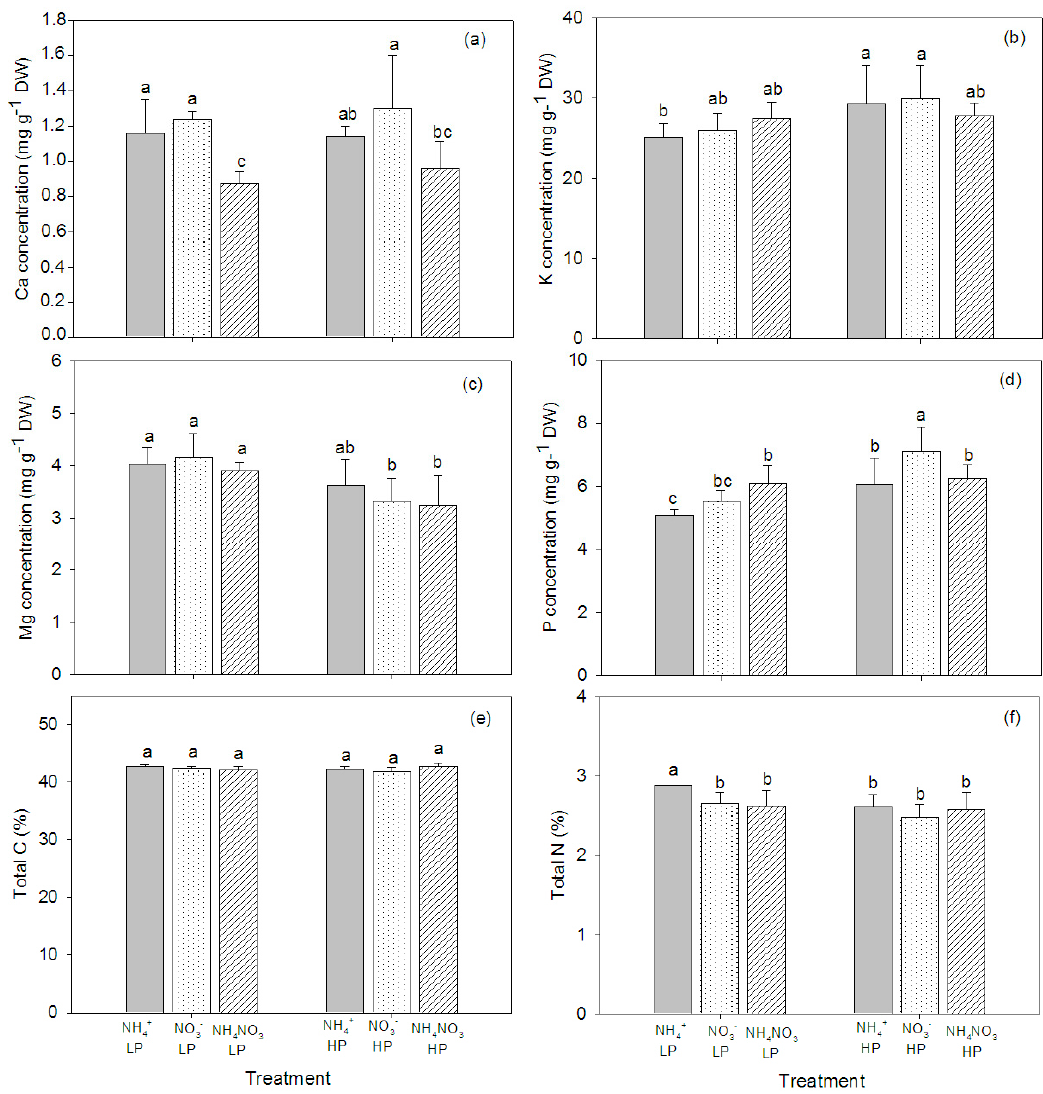
Figure 6. Concentrations of Ca ( a ), K ( b ), Mg ( c ), P ( d ), total C ( e ), and total N ( f ) in roots of hybrid Napier grass ( Pennisetum purpureum × P. americanum ) (mean ± SD) grown on di ff erent N forms (NH 4 + , NO 3 − , and NH 4 NO 3 ) and P concentrations (LP, low P concentration (100 µ M P); HP, high P concentration (500 µ M P)). Di ff erent letters above columns indicate significant di ff erences between treatments.